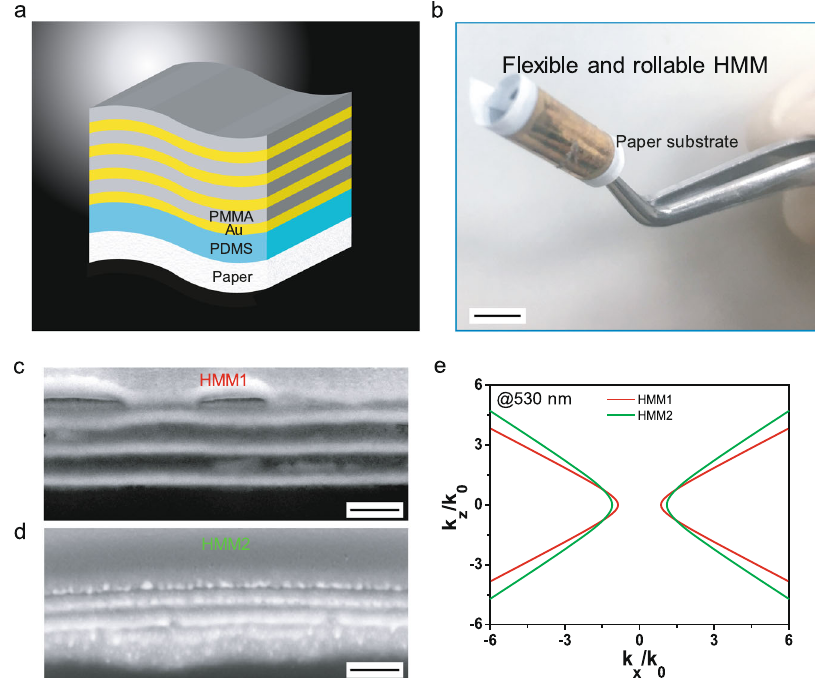
Fig. 1 Proof-of-concept design of the fl exible and rollable hyperbolic metamaterials (HMM). a The schematic diagram of the fl exible and rollable HMM structure. b The fl exible and rollable HMM device in a rolling con fi guration. Scale bar represents 1 cm. c , d Cross-sectional fi eld- emission scanning electron microscopy (FE-SEM) image of the HMM1/HMM2 samples with thicknesses of gold (Au)/poly(methyl methacrylate) (PMMA) for 25/40 and 25/30 nm with four pairs, respectively. Scale bars represent 100 nm. e The iso-frequency curves are plotted at the wavelength of 530 nm for both of the HMM1 and HMM2